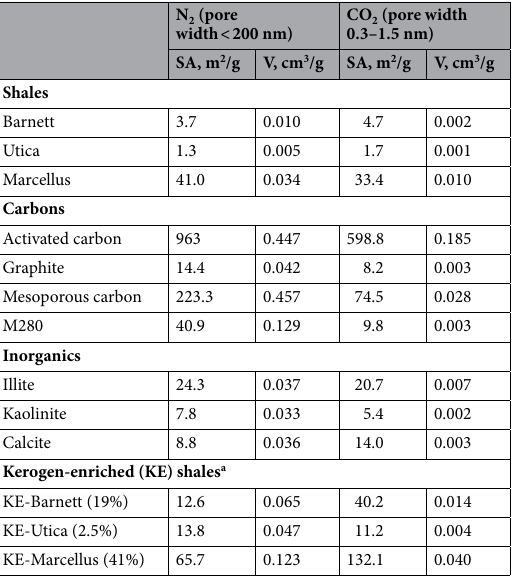
Table 2. Summary of structural parameters derived from nitrogen at 196 °C and carbon dioxide at 0 °C isotherms. a In parenthesis, weight percent of fixed carbon measured as a mass loss at 920 °C in air flow during thermogravimetric analysis (see